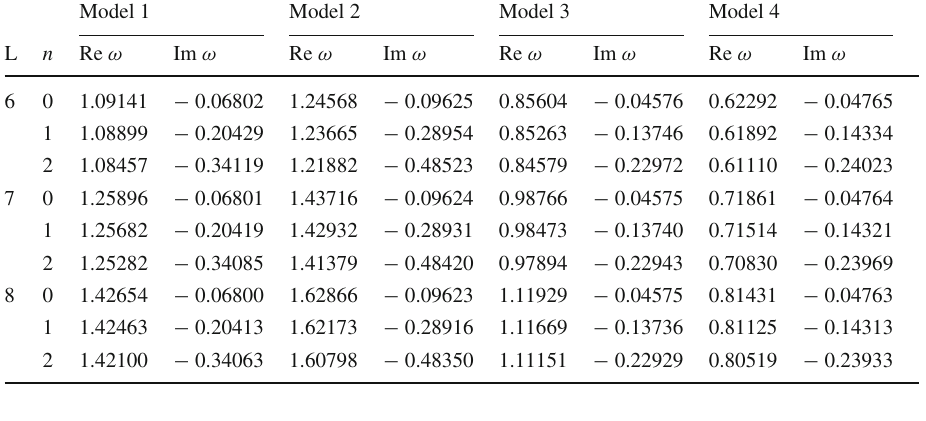
Table 3 Numerical values for Re (ω) and Im (ω) for α =